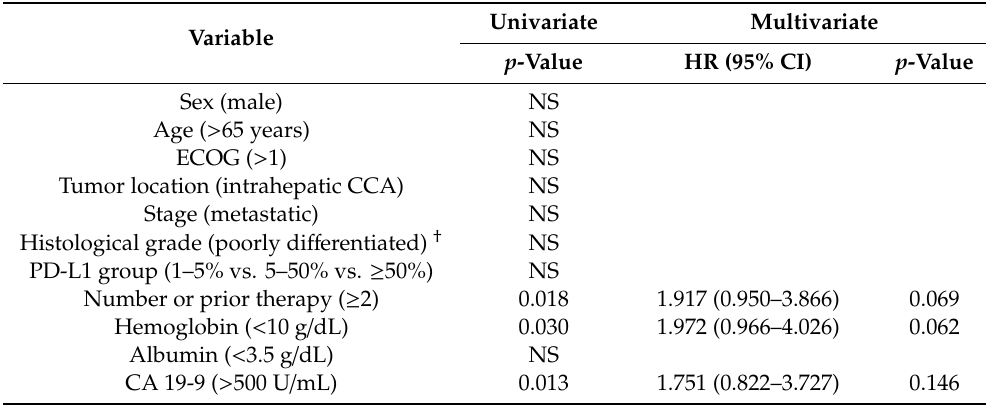
Table 4. Predictors of progression after pembrolizumab treatment.